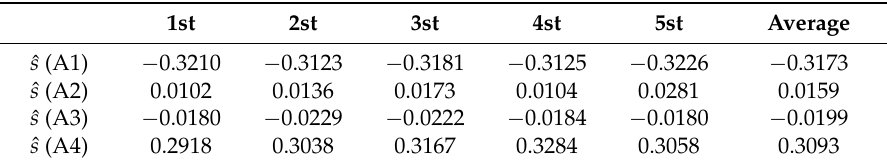
Table 10. The expected values of the clouds.